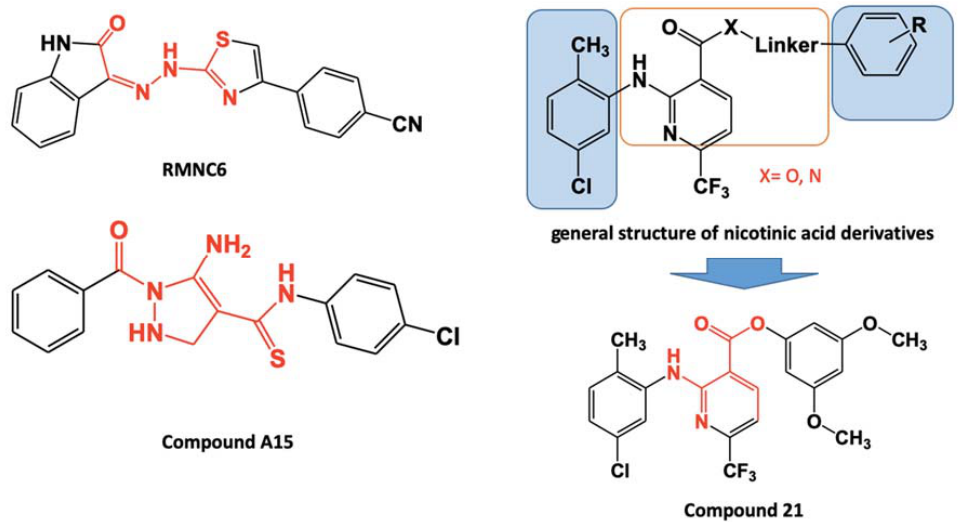
Figure 1. Structure of dual-site dual inhibitors. In red, the functionalized spacer; in black, the aromatic side portions. Summary of the 2-(arylamino)-6-(trifluoromethyl)nicotinic acid derivatives, in blue squares; the aromatic side portions, within red square.